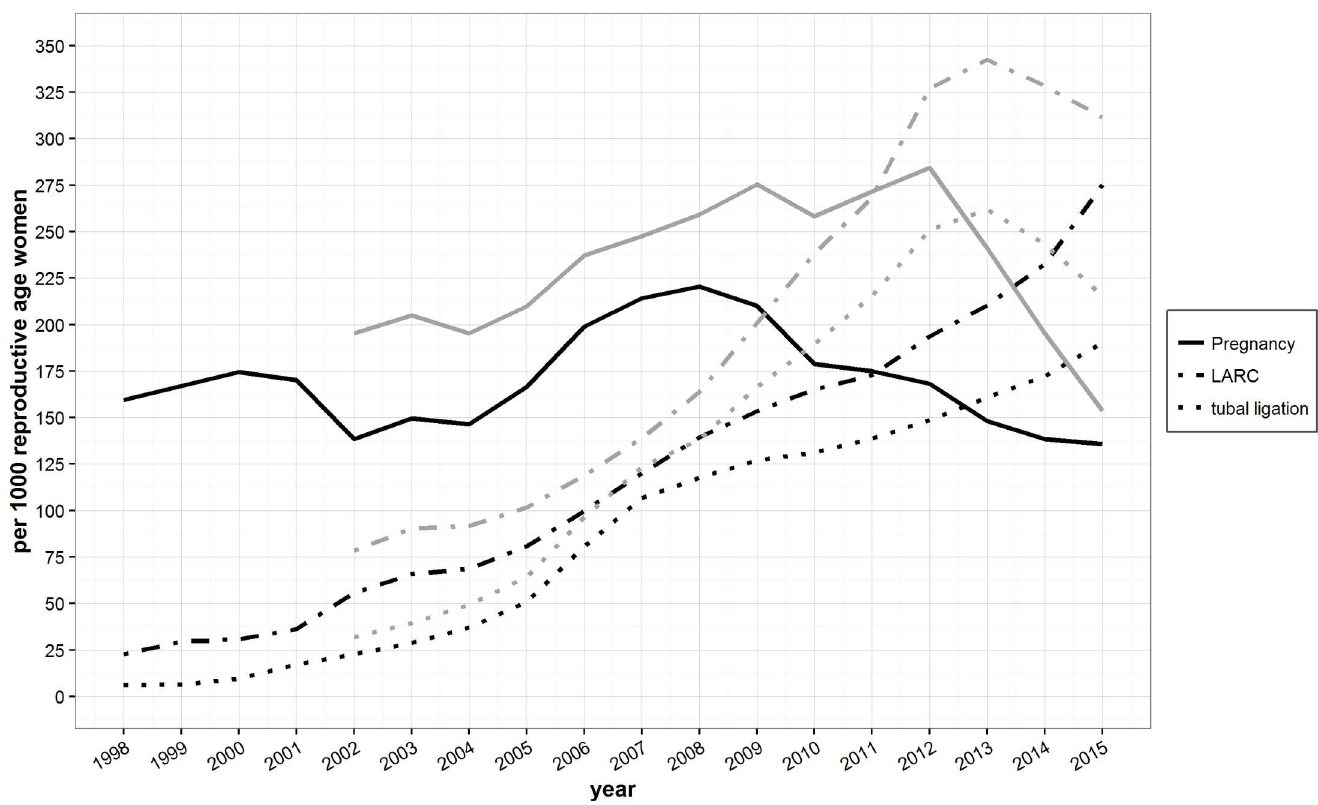
Fig 3. Cumulative uptake of long acting reversible contraceptives ((LARC) implants and IUD) and tubal ligations, and pregnancies per 1,000 reproductive age women using different population estimateorigins (TBBC (black lines) or UNHCR(gray lines)) by